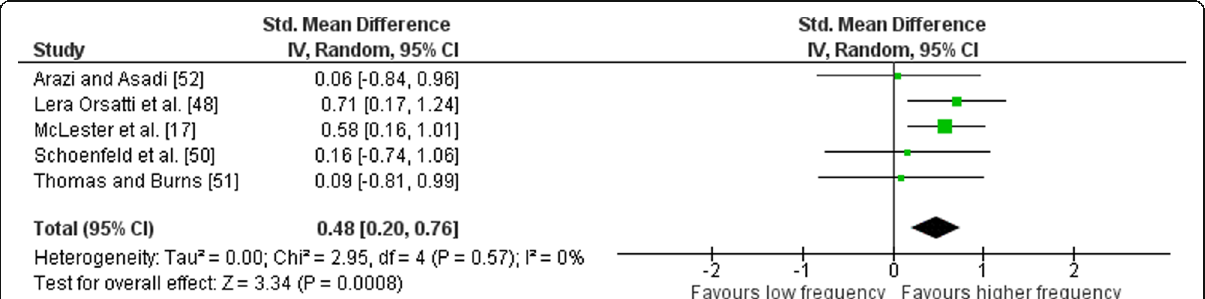
Fig. 10 Low vs. high weekly training frequency. Pre- vs. post-mean ES strength difference on upper body exercise. The vertical line indicates the overall estimate of combined multi-joint and isolation studies pre- vs. post-mean ES strength difference. Horizontal lines indicate 95% CI, squares estimates, whereas square size is proportional to sample size, and rhombs ’ meta-analytically pooled estimates